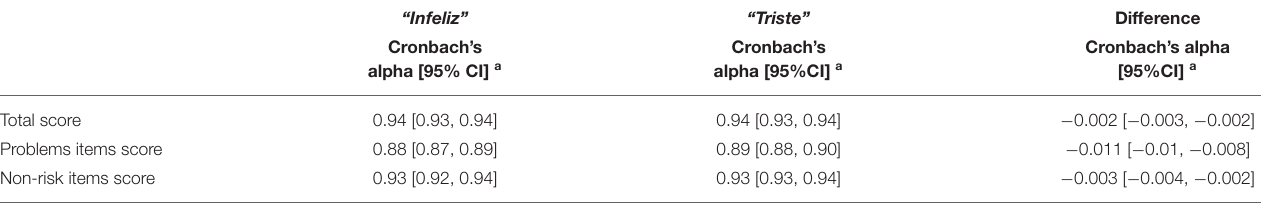
TABLE 4 | Cronbach’s alpha for each item and the difference between them in relation to the total score, problem item score, and non-risk item score.